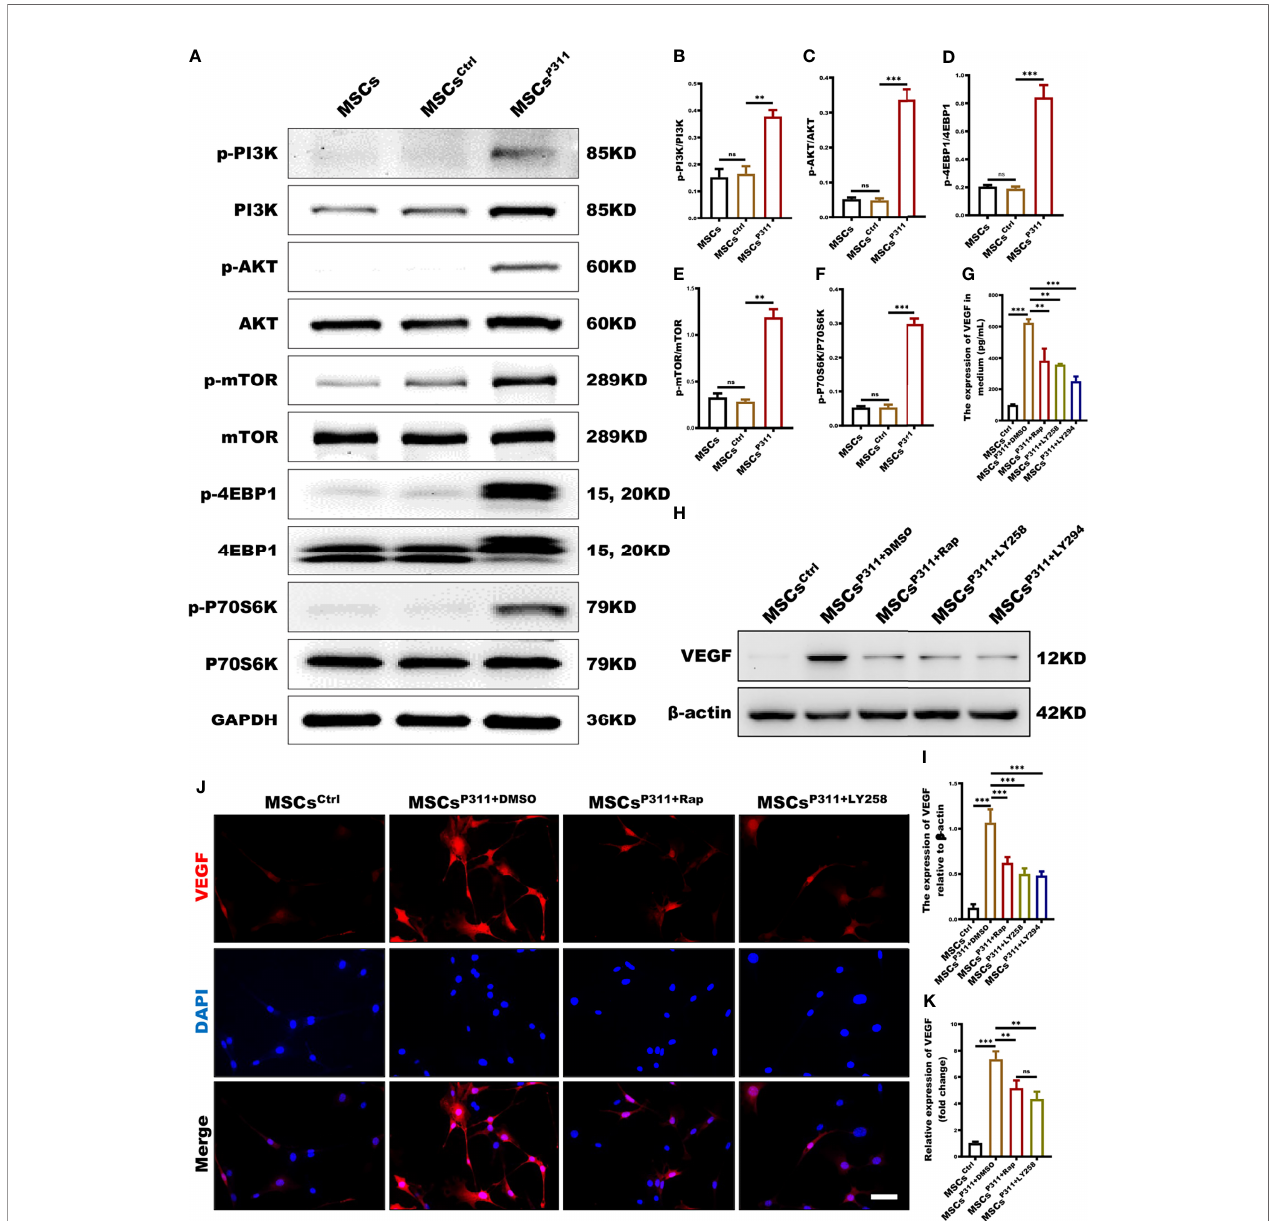
FIGURE 6 | mTOR signalling pathway is deeply involved in the regulation of P311 on VEGF expression in MSCs. (A – F) The activation of mTOR (P70S6K/p-P70S6K, 4EBP1/p-4EBP1, mTOR/p-mTOR, AKT/p-AKT, and PI3K/p-PI3K) signalling pathway in MSCs, MSCs Ctrl and MSCs P311 was detected using Western blot. Representative images for mTOR related signaling pathway were shown (left panel), and the ratio of phosphorylated to total proteins were statistically analysed (right panel). (G – K) The affection of mTOR related signalling pathway on P311-mediated up-regulating VEGF expression of MSCs was estimated by detecting VEGF extracellular secretion, intracellular expression of VEGF in MSCs P311 with rapamycin (mTOR inhibitor), LY2584702 (P70S6K inhibitor), LY294002 (PI3K inhibitor), or control vehicle (DMSO) treatment. (G) The extracellular secretion of VEGF in MSCs P311 with rapamycin, LY2584702, LY294002 or DMSO treatment was examined by ELISA assays. (H – K) The intracellular expression of VEGF in MSCs P311 with rapamycin, LY2584702, LY294002, or DMSO treatment was detected by Western blot and confocal microscopy. (H, I) Representative immunoblotting images for VEGF were shown (left panel), and the mean gray value of VEGF was statistically analysed (right panel). (J, K) Representative fl uorescent images for VEGF were shown (left panel), and the mean fl uorescence intensity value of VEGF was statistically analysed (right panel). Scale bar: 100 µm. Data are representative of at least three independent experiments and represent mean ± SD. (ns, no statistical signi fi cance; **P<0.01; ***p <